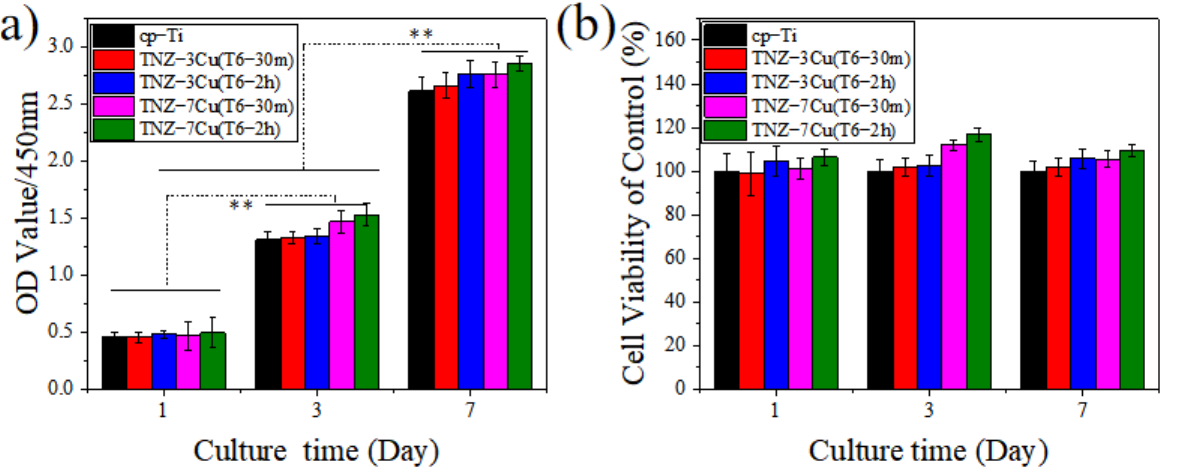
Figure 13. OD value and viability of MC3T3-E1 cells co-cultured with different sample extracts af- ter1-7 days (** p < 0.05): ( a ) OD value at 450 nm, ( b ) Cell viability. after1-7 days (** p < 0.05): ( a ) OD value at 450 nm, ( b ) Cell